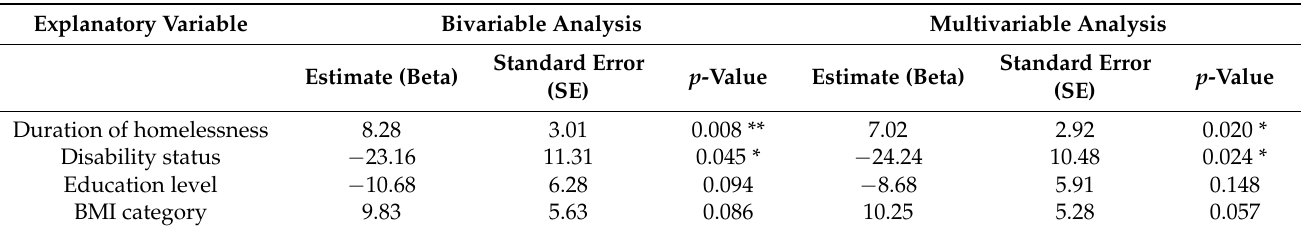
Table 3. Bivariable and multivariable linear regression analyses examining factors associated with total cholesterol level ( n =